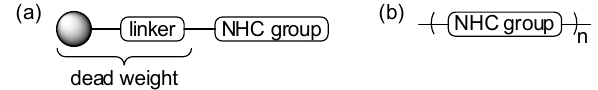
Figure 1. ( a ) Polymer ‐ supported NHC organocatalysts. ( b ) Self ‐ supported NHC organocatalysts. Molecules 2016 , 21 , 1100;